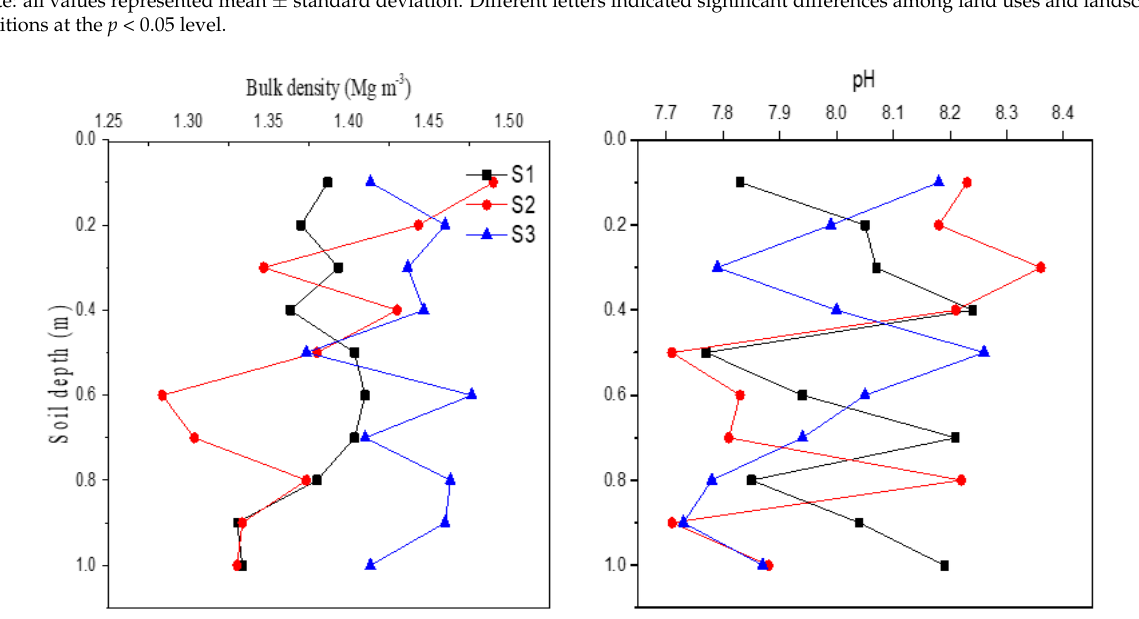
Table 2. Measurement of total organic carbon (TOC), total nitrogen (TN), C:N ratio and stable isotope composition in various source soils and sediments.